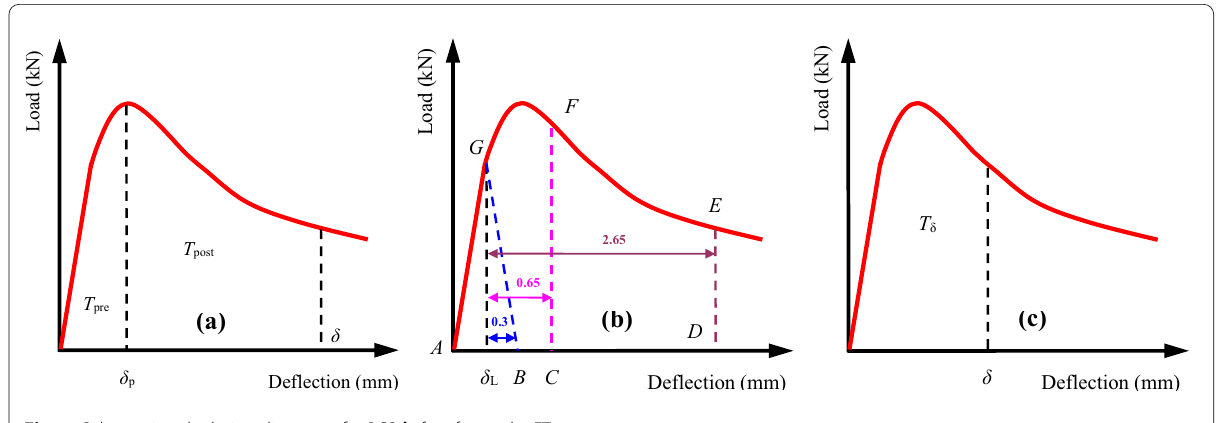
Fig. 4 Schematic calculation diagram of a PCS , b f eq1 , f eq2 and c FT δ